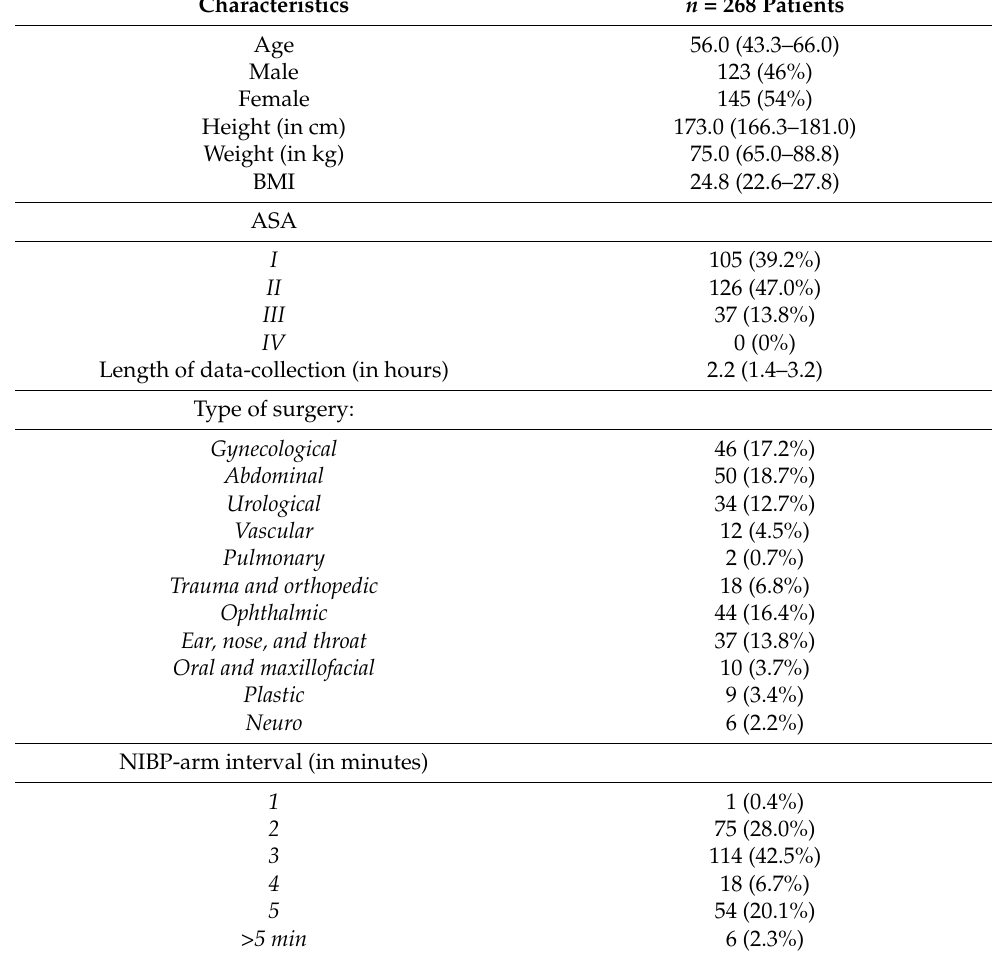
Table 1. Baseline data of included